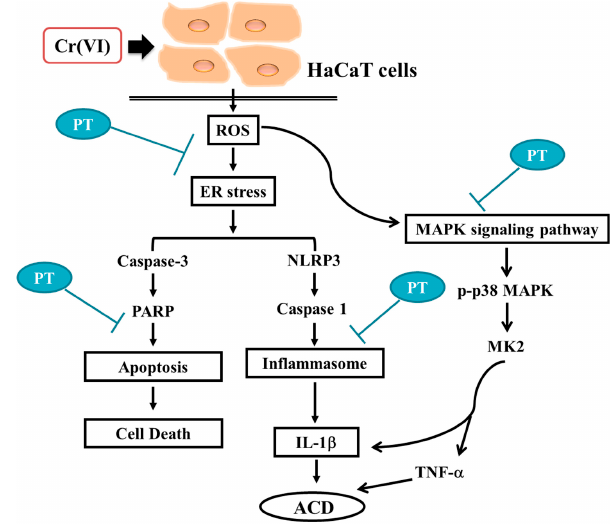
Figure 8. Possible molecular targets of the preventive effects of PT in Cr(VI)-induced ACD. Cr(VI) activated NLRP3 inflammasome activity and the p38 MAPK/MK2 signaling pathway leading to pro-inflammatory gene expression and resulting in keratinocyte cell death by apoptosis. The administration of PT inhibited cell death, the NLRP3 inflammasome and pro-inflammatory cytokines, which were regulated by ROS generation and ER stress and were related to Cr(VI)-induced ACD. Supplementary Materials: The following are available online at www.mdpi.com/xxx/s1, Figure S1: Chemical structure of trans -3,5-dimethoxy-4 ′ -hydroxystilbene (pterostilbene), Figure S2: Percentage of apoptotic cells determined in different Cr(VI) concentrations. The EC50 value for apoptosis was 84.303 μ M. Data presented as the mean ± standard deviation (SD) from three independent experiments, Figure S3: DPPH radical scavenging activity of PT. PT antioxidant activity was assessed via the percent inhibition (radical scavenging) of DPPH. Vitamin C (200 μ M) was used as a positive control. All tests were performed in triplicate and results are expressed as means ± SD.